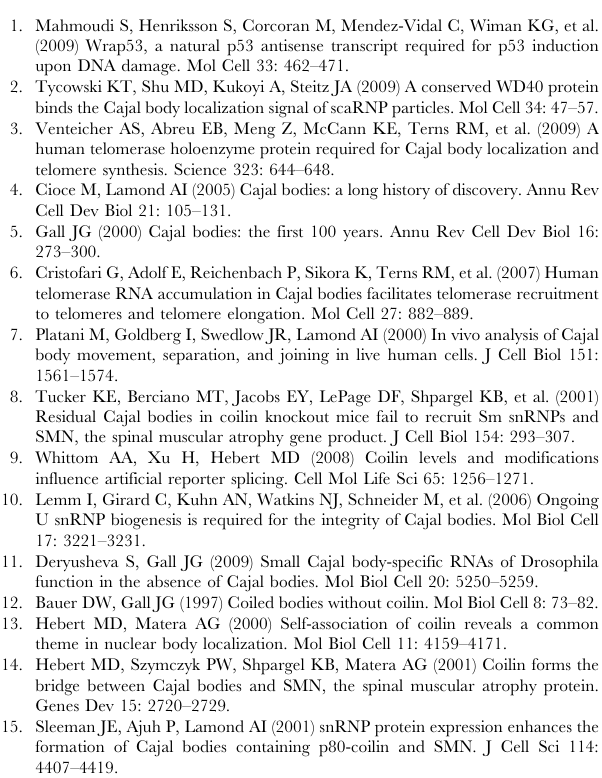
length (bottom) antibodies. (C) Immunostaining of endogenous WRAP53 using the a -WRAP53 (Wdr79) antibody and FA fixation protocol in U2OS cells. Shortly, cells were grown on sterilized cover slips and fixed with 4% FA for 10 min at room temperature. secondary antibody diluted in blocking buffer. The cover slips were mounted with Vectorshield mounting medium with DAPI (Vector Laboratories). Figure S4 Stable Flag-WRAP53 cells with high WRAP53 expression lack Cajal bodies. (A) IF analysis of U2OS cells stably transfected with either Flag–Empty vector (Mock cells) or Flag-WRAP53 (Flag-WRAP53 cells) stained for WRAP53 and coilin. (B) WRAP53 interacts with SMN both in the cytoplasm and in the nucleus. In situ PLA of WRAP53–SMN interaction in WRAP53-depleted U2OS cells as negative control. A clear reduction in in situ PLA signals was observed in siWRAP53 compared to siControl, confirming the specificity of detection in Figure 5E. Co-IF with WRAP53 is shown in green, and the nuclear staining in blue. Figure S5 Aberrant expression of WRAP53 leads to mislocalization of Gemin3 and Gemin2. (A) WB analysis of WRAP53 and SMN levels in fractionated U2OS cells treated with the indicated siRNA oligos for 48 h. Lamin A/C and Hsp90 were used as nuclear and cytoplasmic markers, respectively. (B) IP of endogenous WRAP53 from U2OS cells pretreated with the